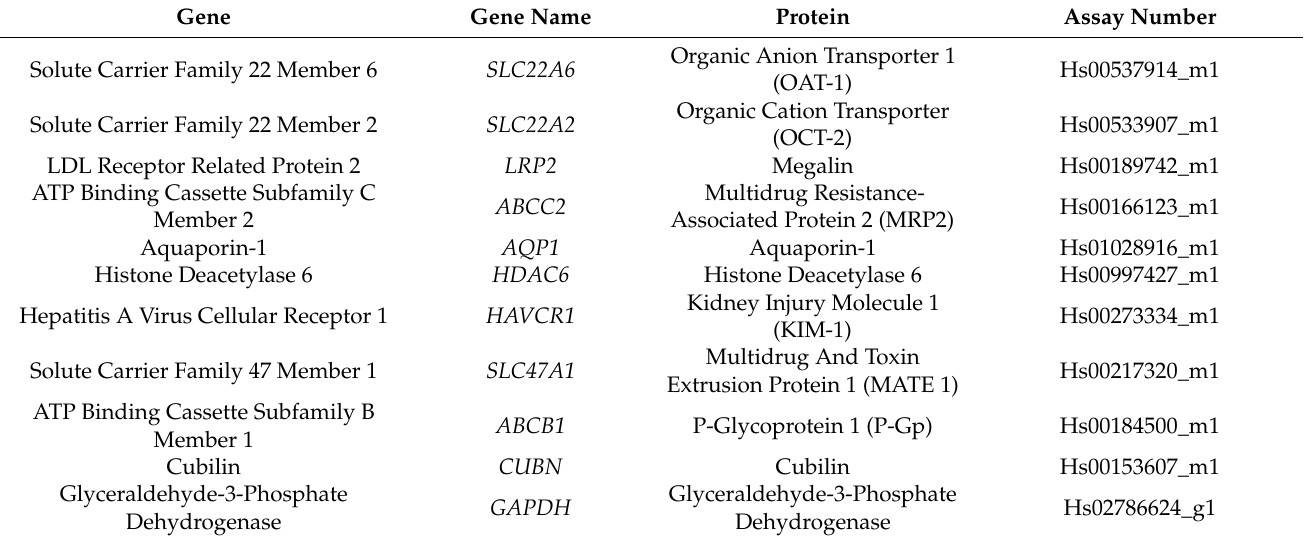
Table 1. List of genes investigated by qRT-PCR, their encoded proteins, and the specific assay numbers from the provider (Thermo Fisher Scientific). GAPDH was used as the housekeeping